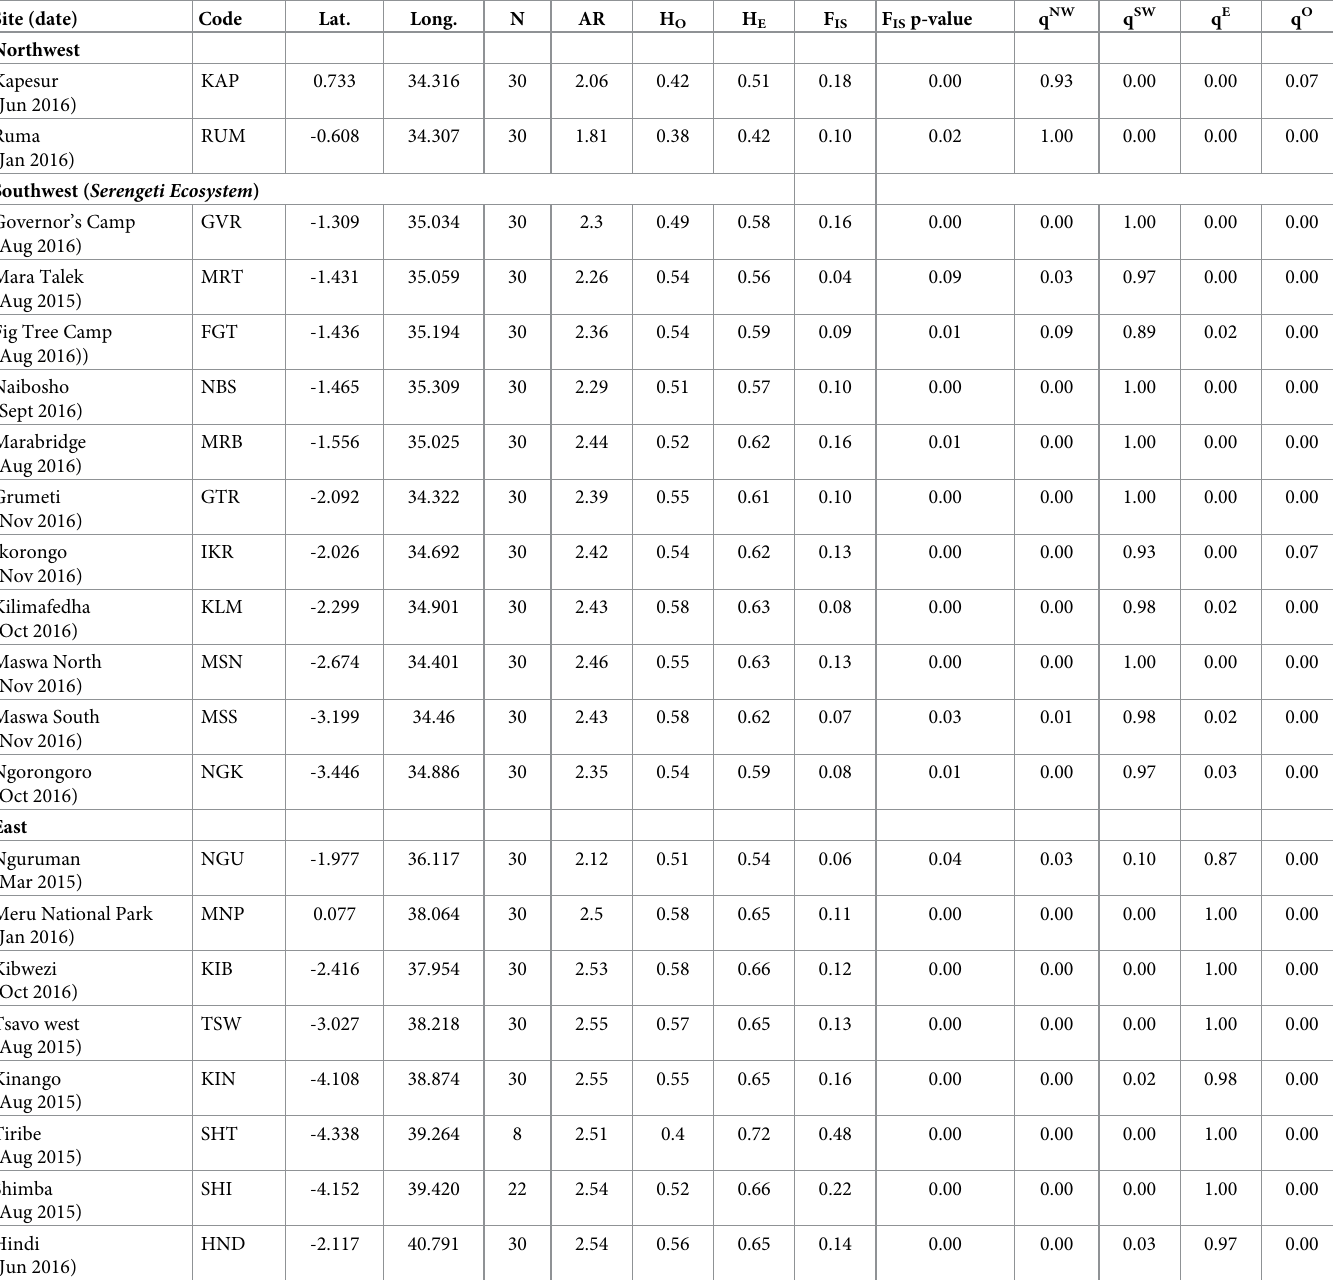
Table 1. Sampling sites and estimates of their genetic diversity and assignment. Site